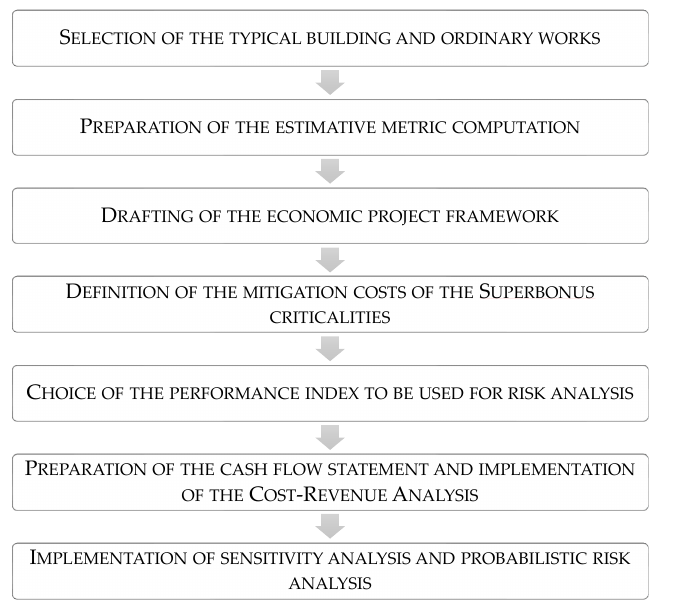
Figure 1. Flowchart of the methodological approach.